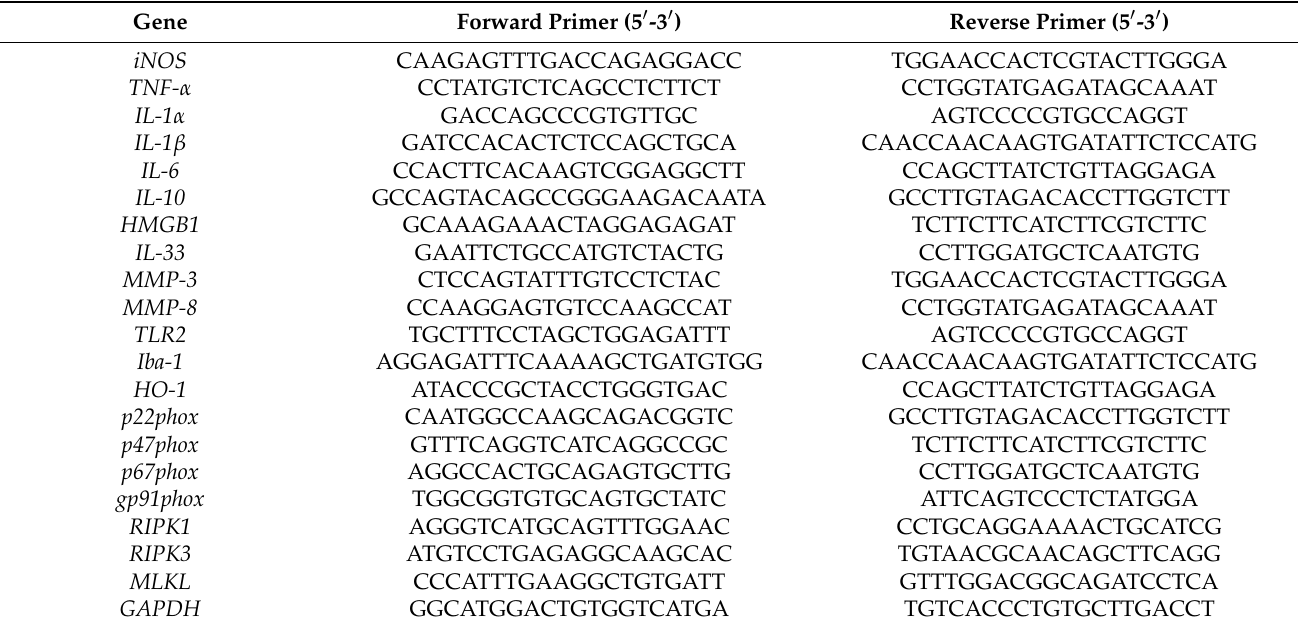
Table 1. Primer sequences used for